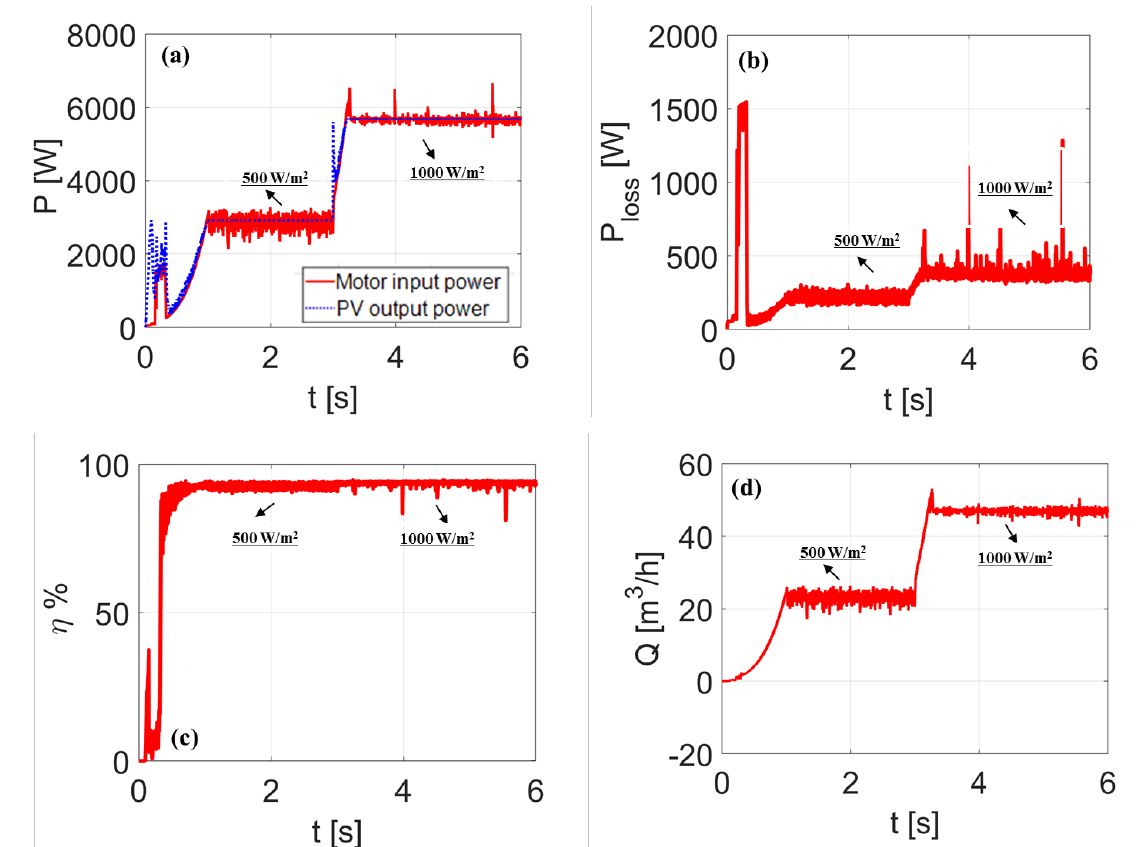
Figure 6. ( a ) The PV array output power and the motor input power versus time. SynRM q-axis current versus time. ( b ) SynRM motor power losses versus time. ( c ) SynRM efficiency versus time. ( d ) The pump flow rate versus time.